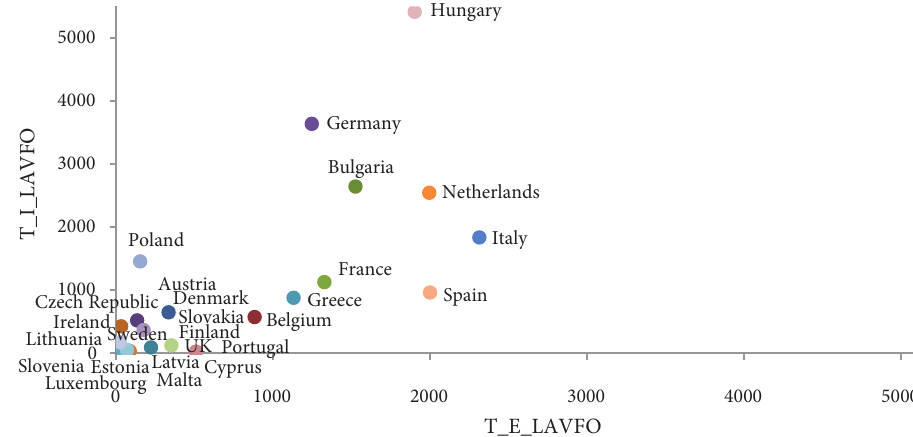
4. Romanian’s Total exports and Total imports of live animals and animal products, vegetable products, vegetable or animal fats and oils with 26 countries of EU, 2007–2016 (mil. euro) (source: authors’ own